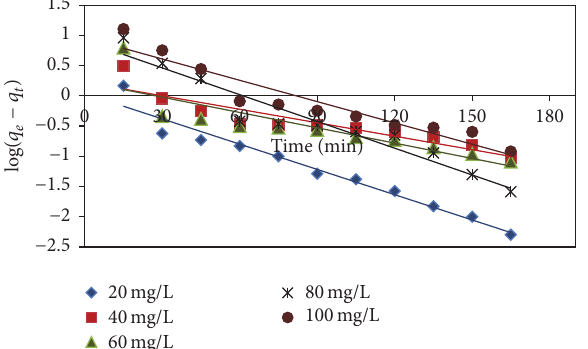
100 mg/L 100 mg/L Figure 18: Pseudo-first-order kinetic model for adsorption RR-RB in binary system with RB-5 (temp. = 25 ∘ C, speed = 200 rpm, dose = 0.1g/100 mL, and con. of RR-RB = con. of RB-5). Figure 20: Pseudo-second-order kinetic model for adsorption RR- RB in binary system with RB-5 (temp. = 25 ∘ C, speed = 200 rpm, dose = 0.1 g/100mL, and con. of RR-RB = con. of RB-5). log (𝑞 𝑒 − 𝑞 𝑡 ) versus time ( 𝑡 ) as shown in Figures 17 and 18.